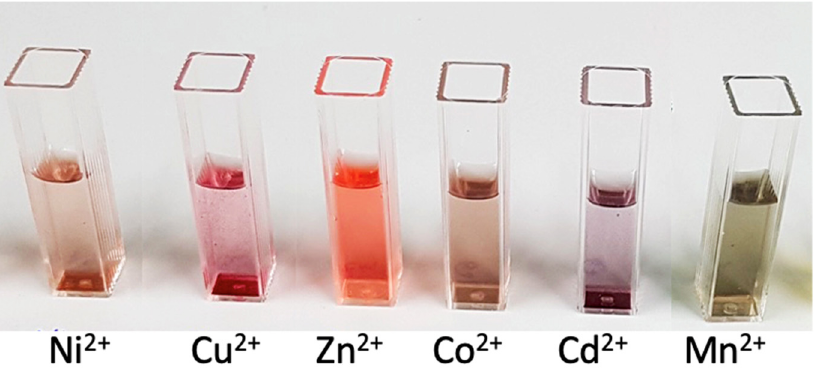
Figure 10. PL 1 -AgNPs@11MUA upon the addition of each metal ion at the highest concentration of metal ion added before the collapse. metal ion added before the collapse.